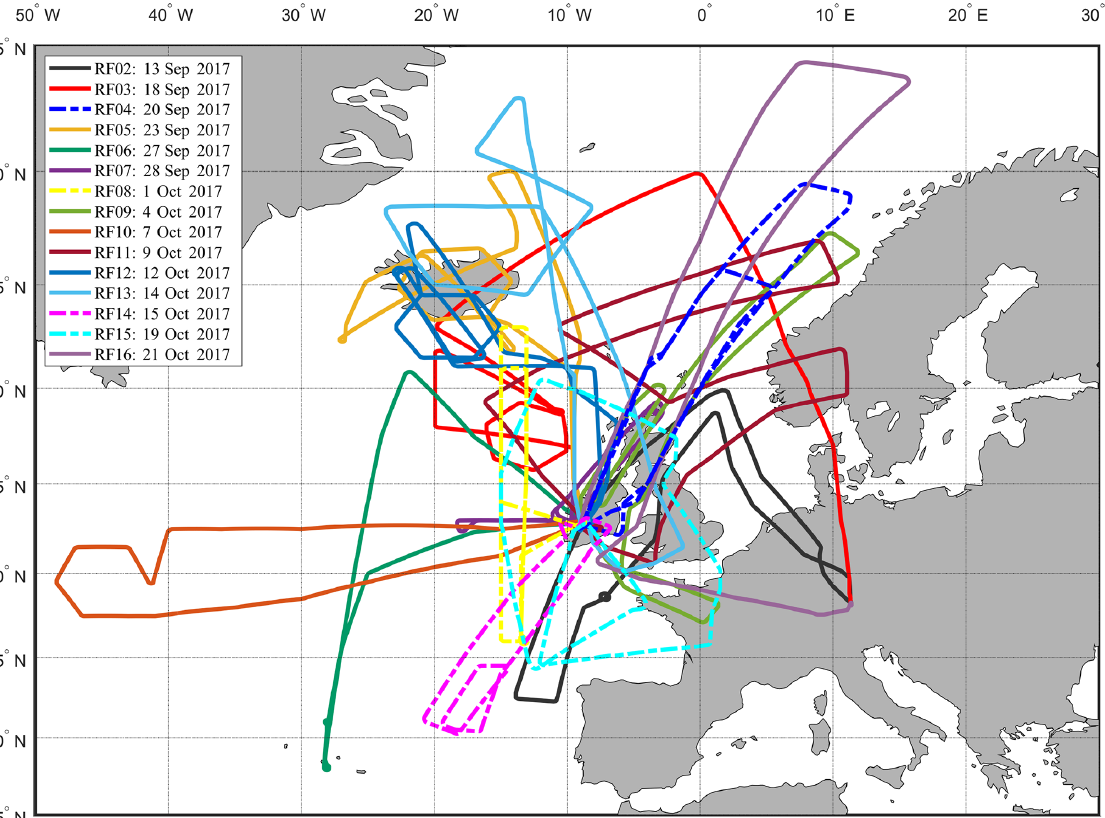
Figure 1. Trajectories of the 15 HALO flights during the WISE campaign in the midlatitudes to high latitudes over the North Atlantic Ocean, Norwegian Sea, and northwestern Europe in the UTLS from 13 September until 21 October 2017. A prior test flight (RF01) is not included in this study. The first research flight, RF02, was conducted locally from the home base in Oberpfaffenhofen, Germany, and all subsequent flights were based from Shannon, Ireland, aside from the transfer flights. The flights illustrated by the dashed lines, i.e., RF04 (blue), RF08 (yellow), RF14 (magenta), and RF15 (cyan), are discussed in the